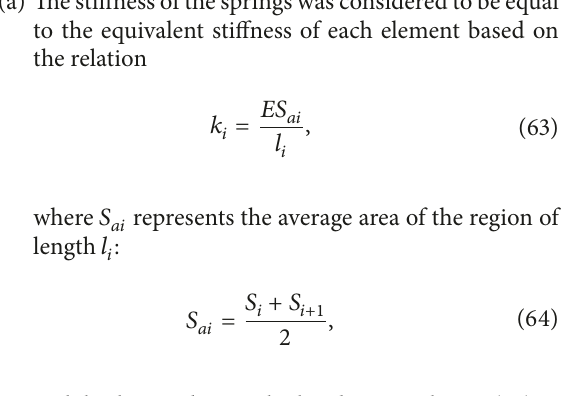
Figure 4: The signal magnitude along the horn.